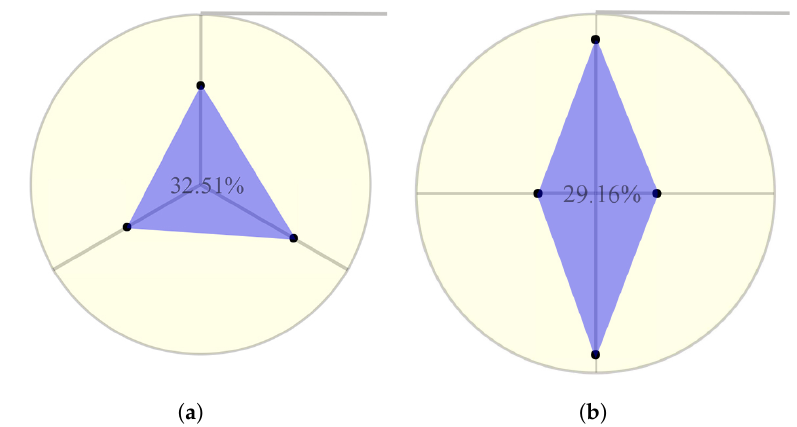
Figure 10. Radar Graphs when entities have been selected. ( a ) Papers have three criteria; ( b ) Journals have four criteria.